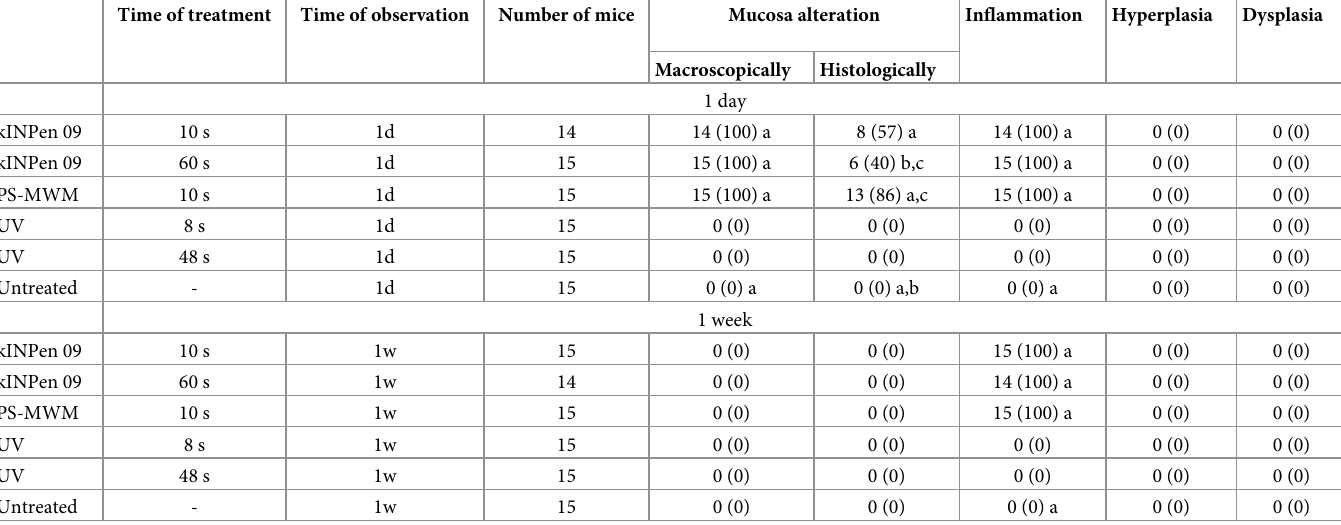
Table 2. Overview of mucosal alterations. Time of